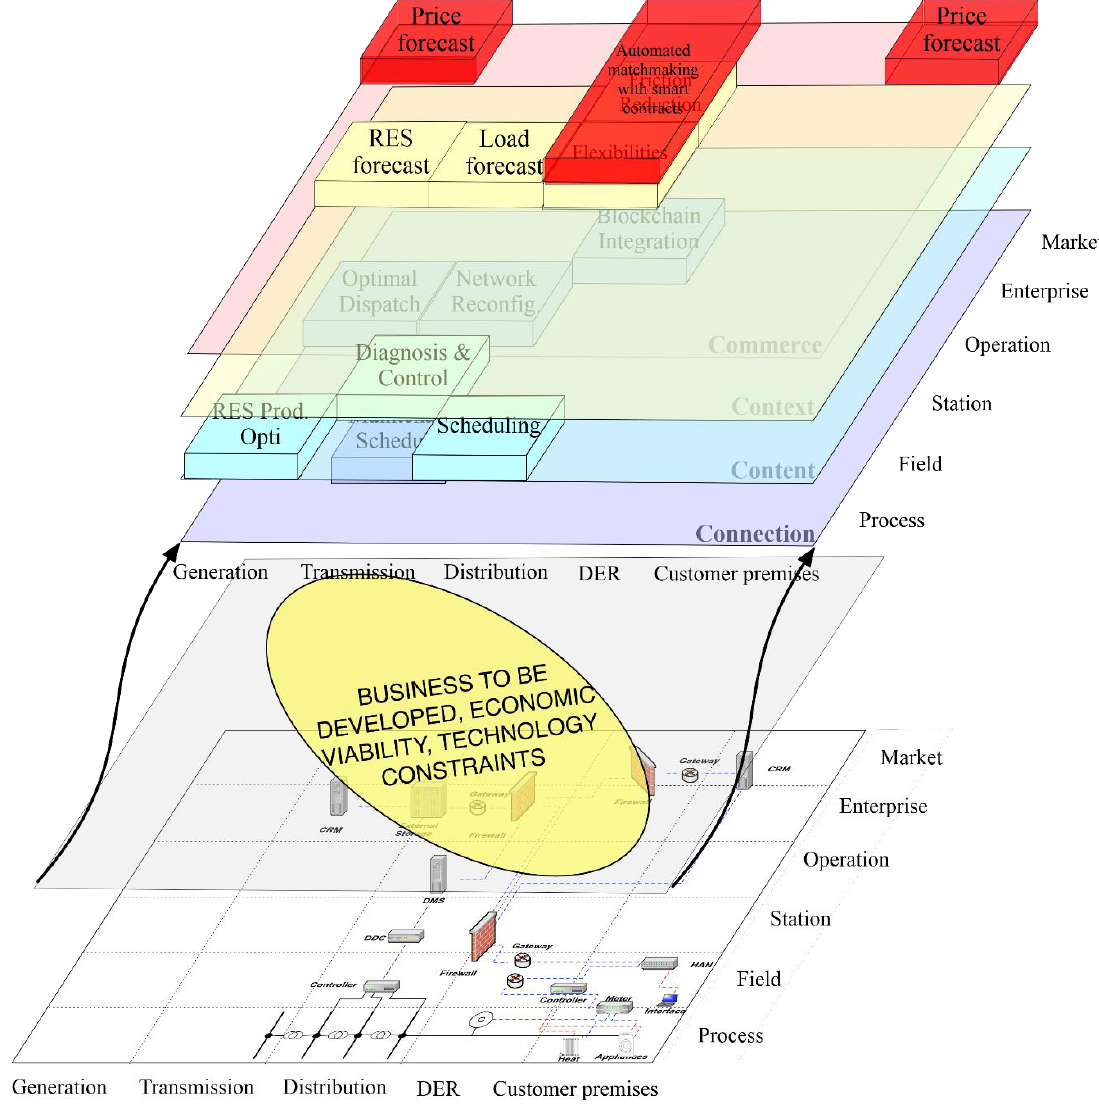
Figure 2. Integrating the 4C framework within the smart grid architecture model (SGAM).